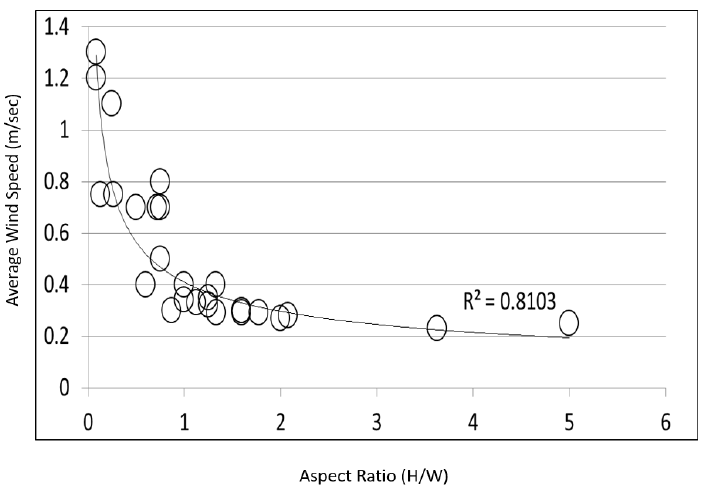
Figure 16. Average Wind Speed in Canyon with Flow vertical or slightly oblique to the canyon axis. For all canyons that have their axis parallel to the wind direction, a strong correlation is observed between the length of the canyon and the product of the entry wind speed and width of the canyon as well as with the product of the exit wind speed with the width of the canyon (Figure 17).